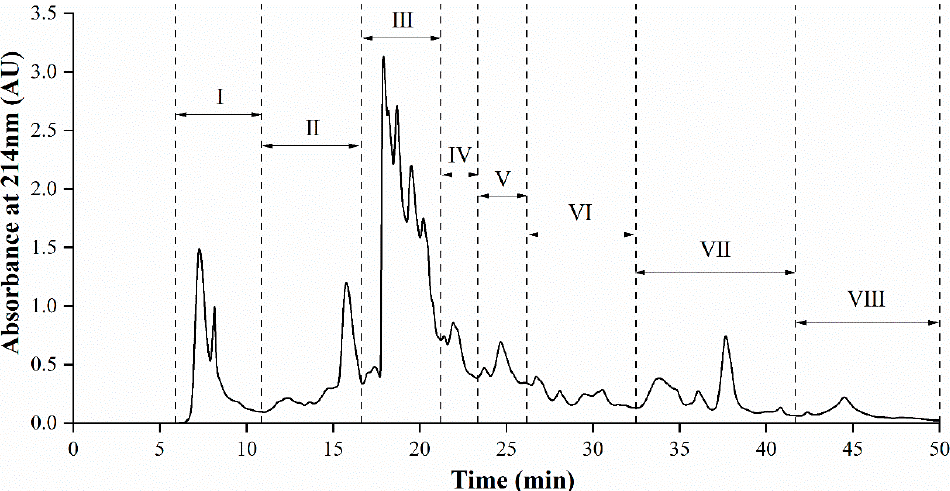
Figure 3. Reversed phase high performance liquid chromatography (RP-HPLC) elution profile of Alcalase-generated DDSG-PI hydrolysate (<1 kDa) after ultrafiltration. The eluates were collected by every tube and combined into eight different fractions labeled I–VIII.